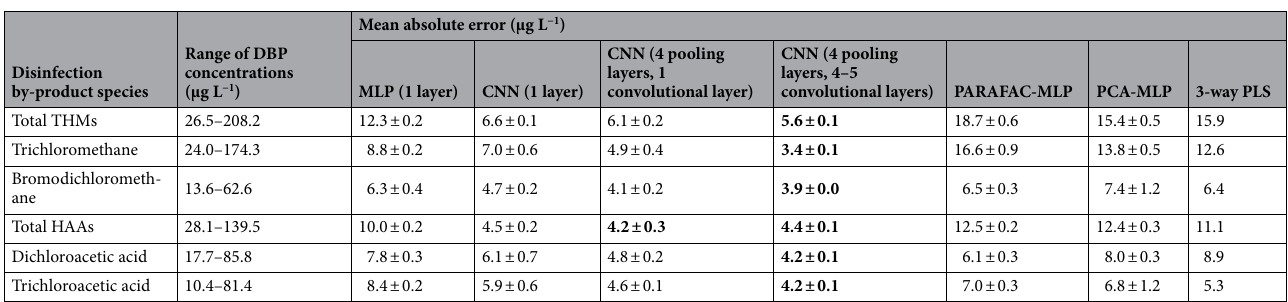
Table 1. Mean absolute error (MAE) of predictions on tests set for several model types. Range or error (±) is calculated as the 95% confidence interval, where applicable. Bolded numbers represent the optimal model for each species as determined by t tests at 95% confidence